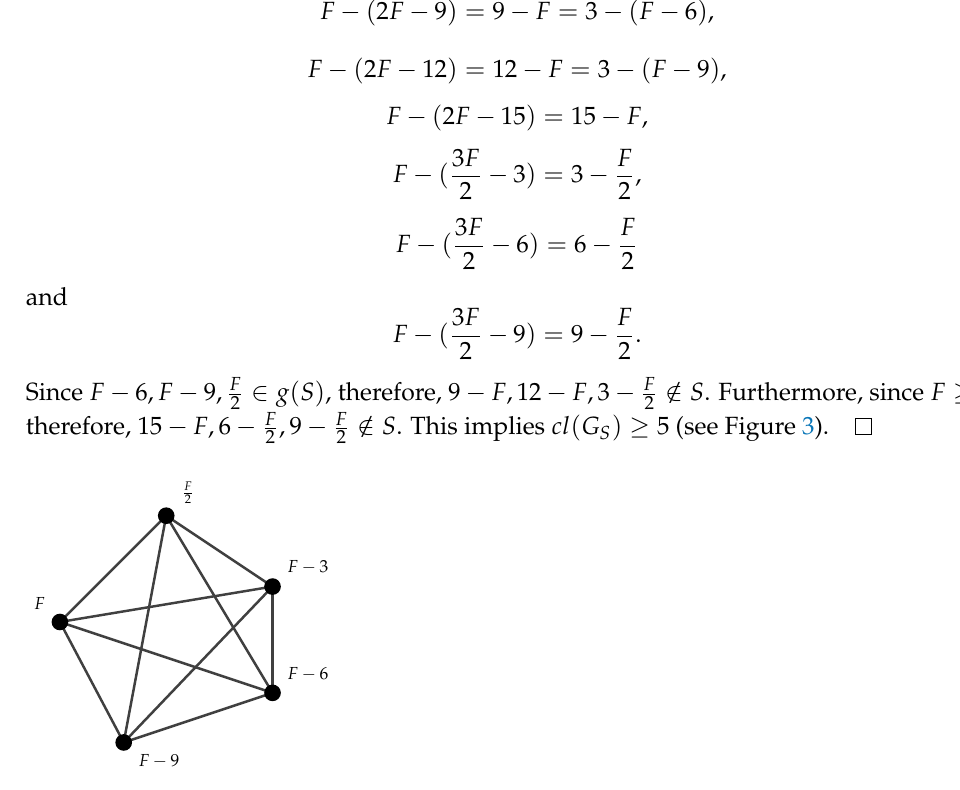
Figure 3. Minimum possible clique for the case m = e = 3 and | G S | >